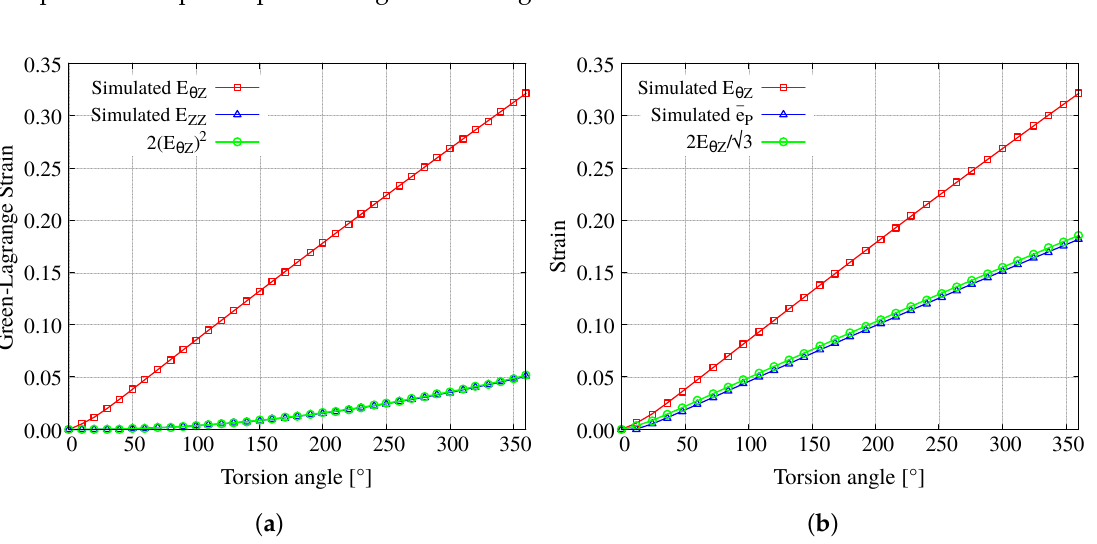
Figure 14. Verification of the analytical expressions for ( a ) E ZZ and ( b ) ¯ e p using E θ Z obtained from the